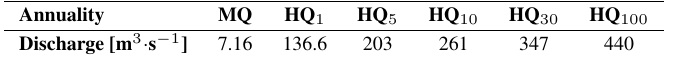
Table 1. Annuality discharge statistics, MQ = mean discharge, HQ recurrence interval of n years.